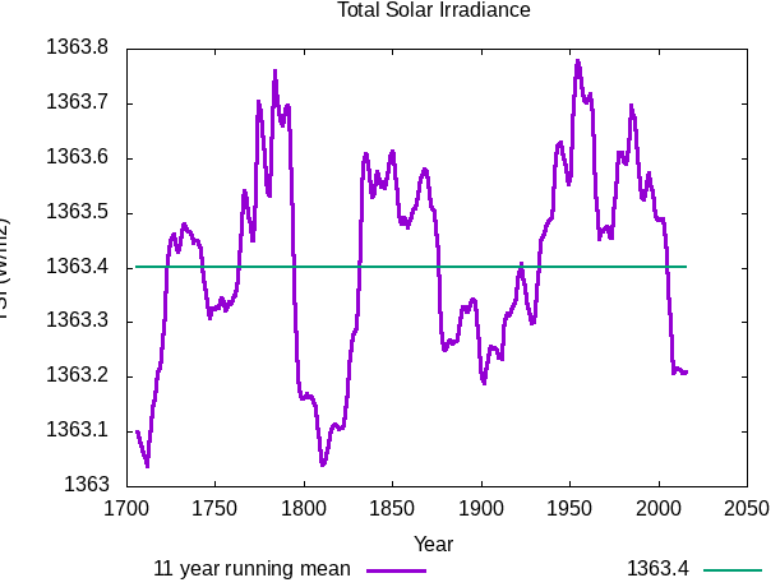
Figure 5. Purple curve: 11 year running mean of annual TSI between 1700 and 2020. Green line: long-term average of the TSI from 1700 to 2020: 1363.4 W/m 2 .